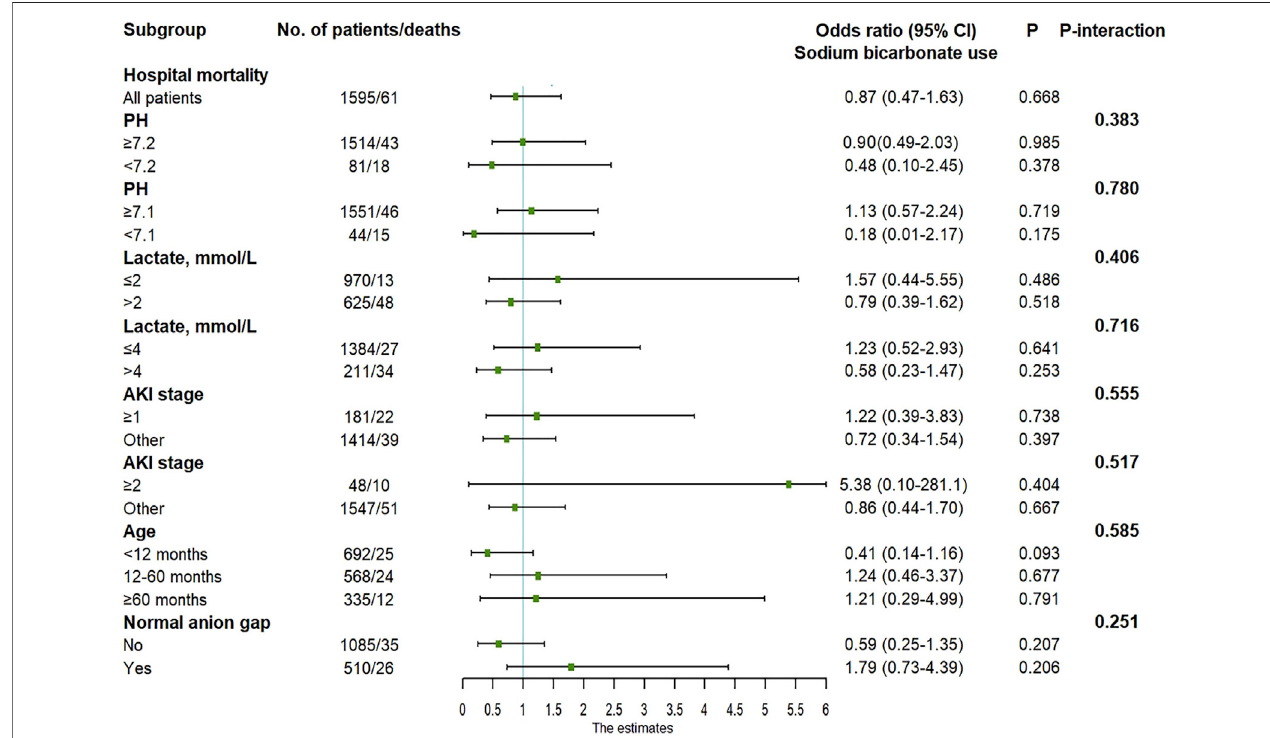
FIGURE 2 | Adjusted odds ratio in the subgroup analysis. AKI, acute kidney injury; CI, con fi dence interval.